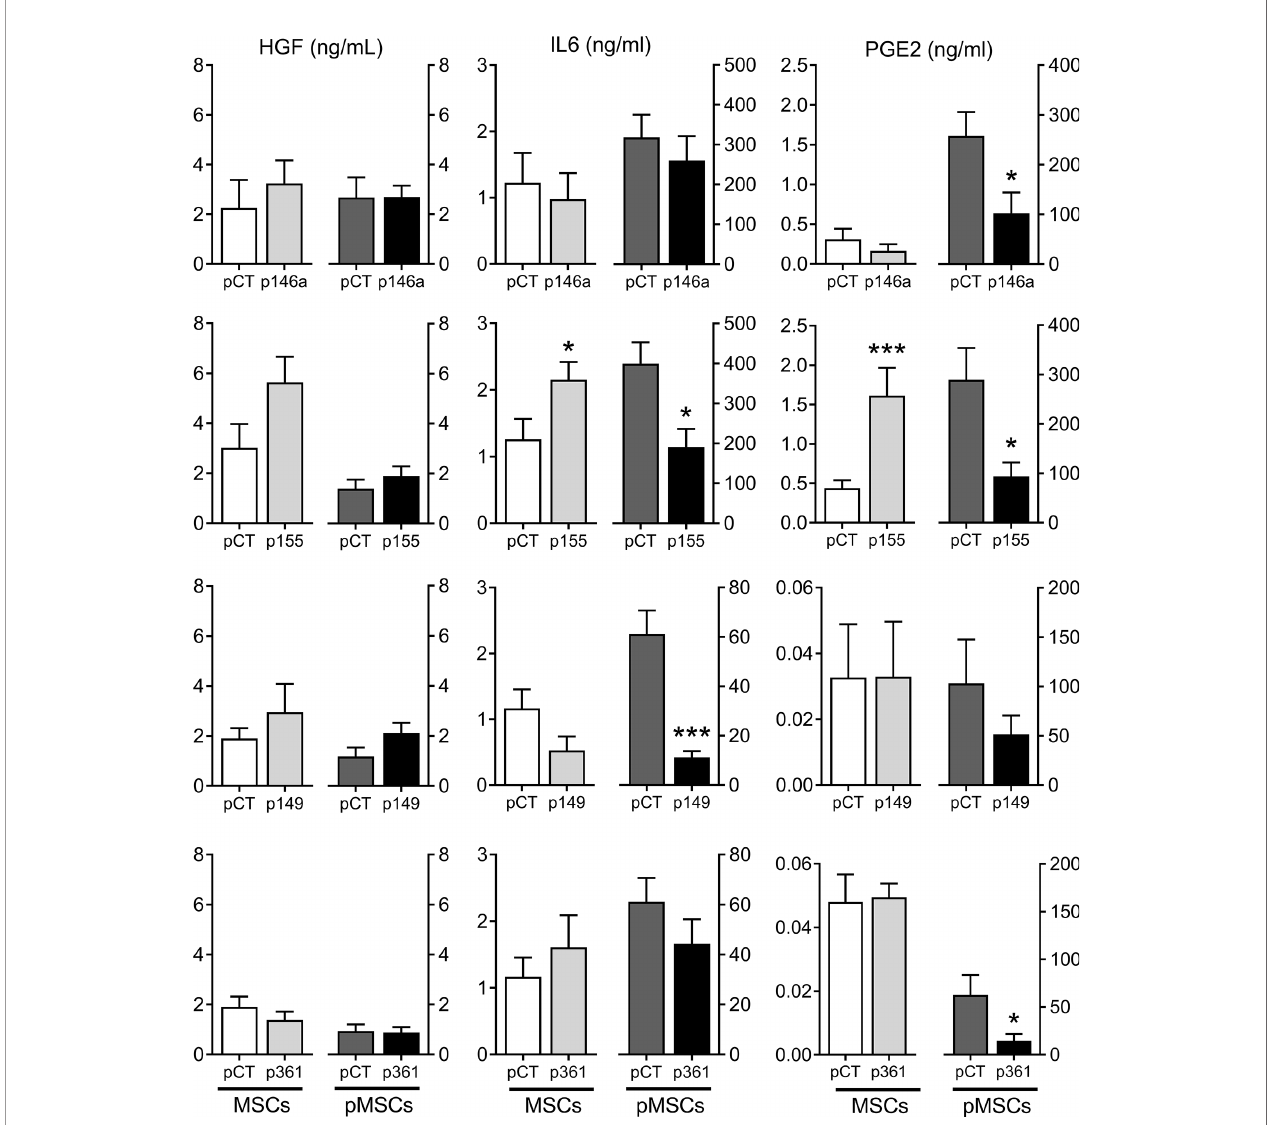
FIGURE 4 | Production of known immunosuppressive factors by MSCs over-expressing miRNAs. Protein levels of HGF, IL6, PGE2 in the supernatants of MSCs cultured alone (MSCs) or pMSCs:aPBMC cocultures (pMSCs), using premiRNA control (pCT) or p146a-, p155-, p149-, p361- transfected MSCs, determined by ELISA (n=6-10 biological replicates). Statistical analysis used unpaired-t or Mann-Whitney test when data assumed normality or not, respectively, with *p < 0.05; ***p <